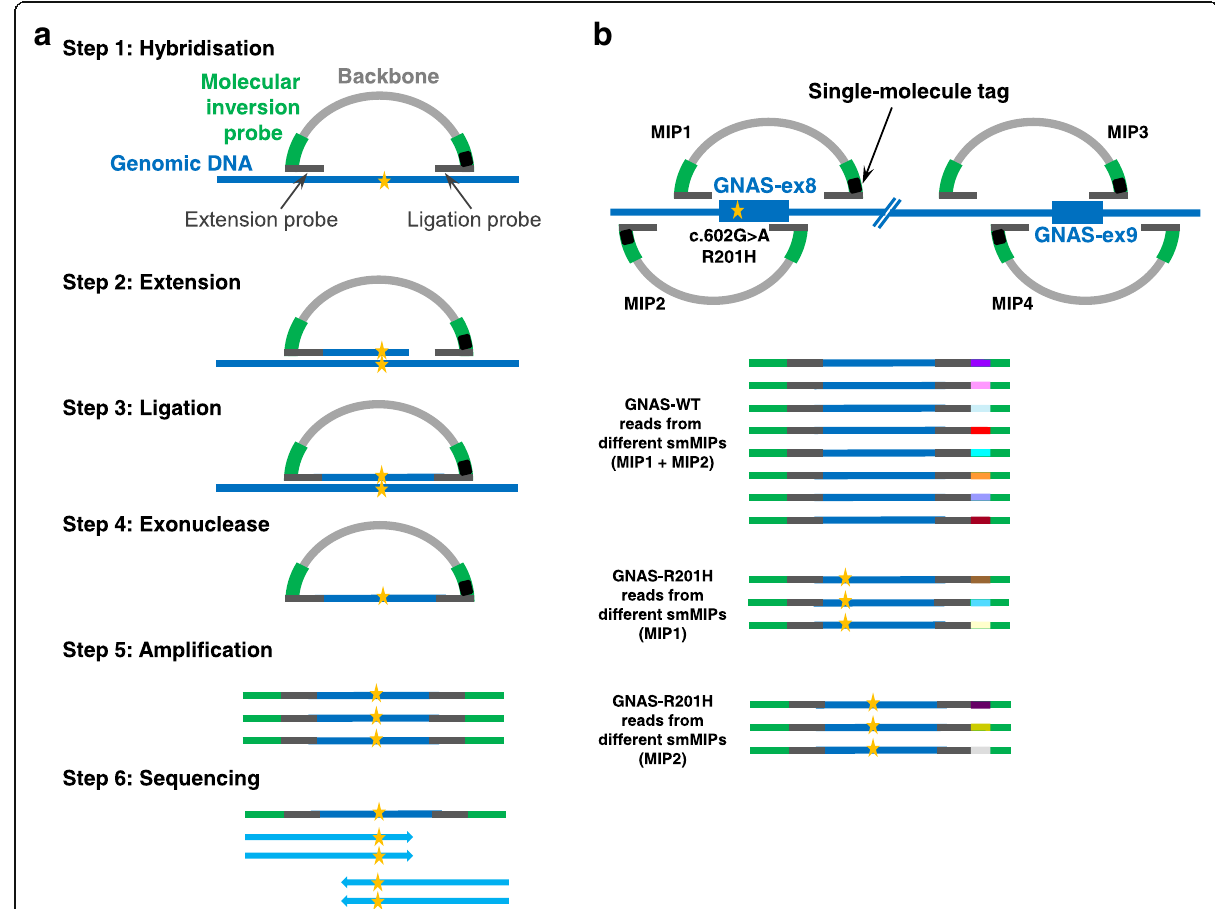
Fig. 3 Schematic overview of the smMIP assay. ( a ) First, the single molecule molecular inversion probe (smMIP) capture procedure is performed. smMIPs are long oligonucleotides consisting of two targeting arms (extension probe and ligation probe), joined by a backbone. The probe sequences are complementary to genomic DNA sequences surrounding the target region that covers a hotspot location (indicated by the yellow asterisk). During the capture reaction, smMIPs are hybridized to genomic DNA (gDNA), followed by an extension and ligation reaction, which results in circular smMIPs. Subsequent exonuclease treatment will remove all linear gDNA and unused smMIPs. Between the backbone and probe sequences are primer sequences (green bars) that are used to amplify the target region, followed by library preparation and next-generation sequencing (NGS). ( b ) By including a single-molecule tag of 8 random nucleotides (N 8 ) at the end of the ligation probe, duplicate reads can be identified and merged into a consensus thereby removing PCR and sequencing artifacts. Genuine C > T and G > A mutations can be distinguished from deamination artifacts by strand specific amplification of the smMIPs. In our smMIP design, exon 8 and exon 9 of the GNAS gene are each covered by two independent smMIPs targeting both strands (smMIP1 – 2 and smMIP3 – 4,